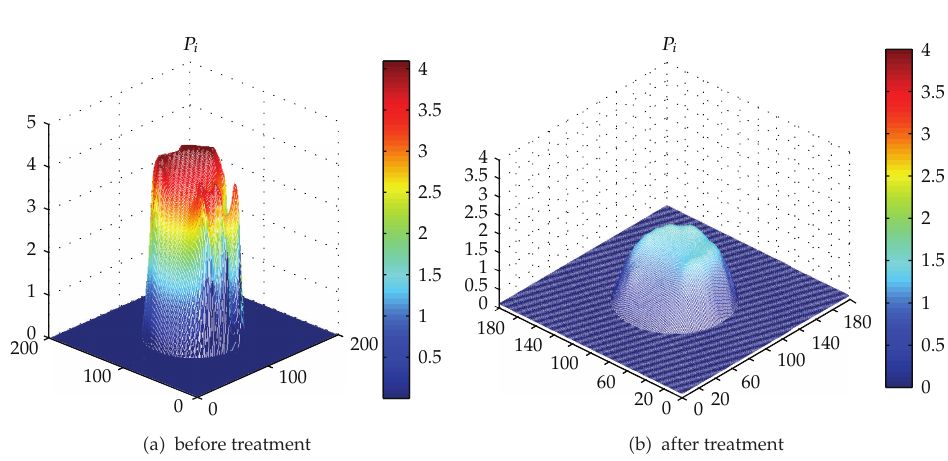
Figure 3: The simulation results of blood perfusion. P i is the interstitial fluid pressure (cid:2) IFP (cid:3) .